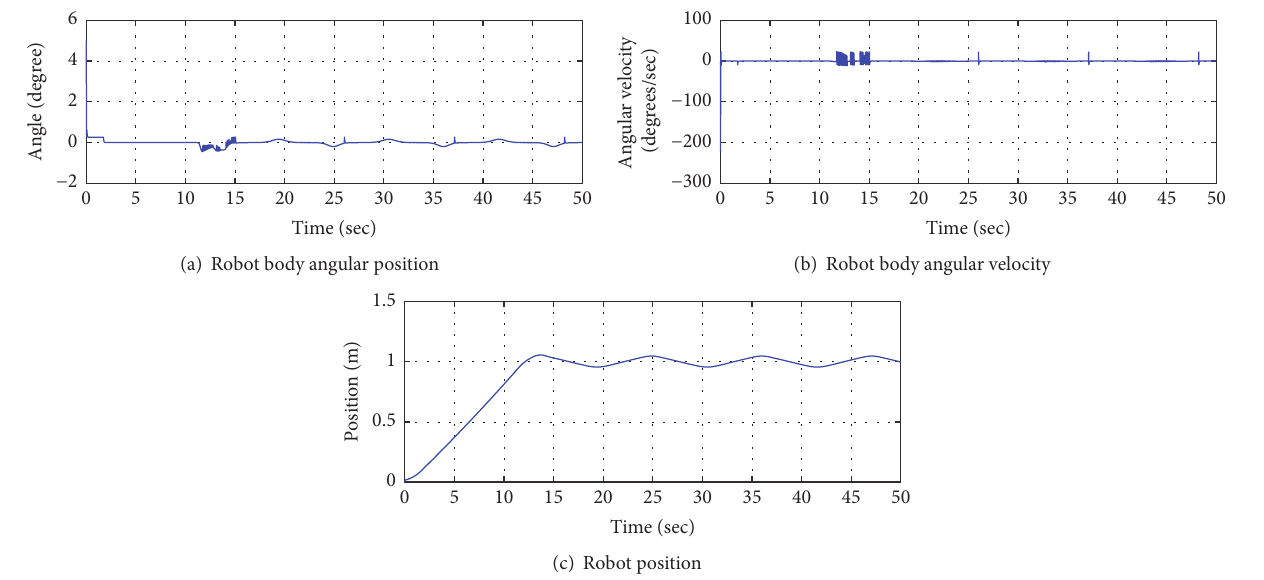
́𝜃 = 0 , and the referenced